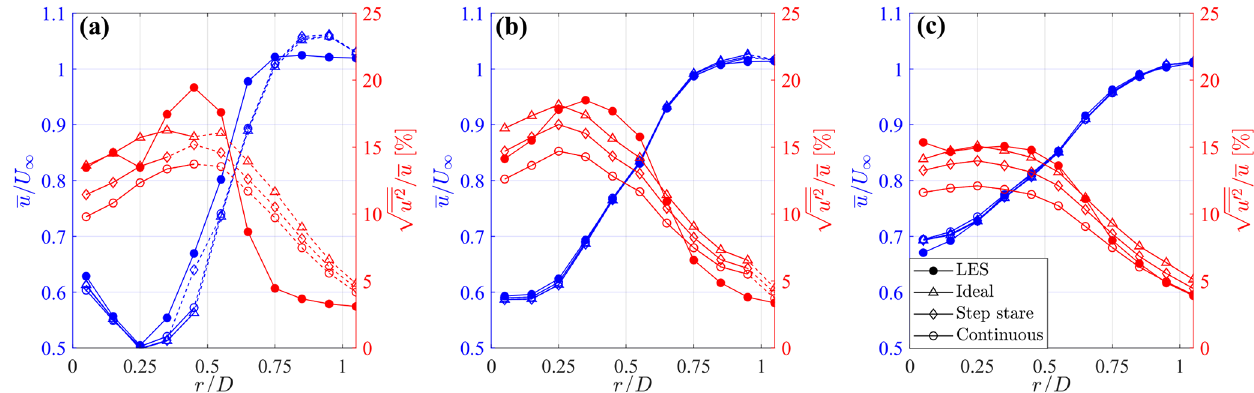
Figure 15. Azimuthally averaged profiles of mean streamwise velocity and turbulence intensity for three downstream locations. (a) x/D = 2 . 25, (b) x/D = 4 . 125, and (c) x/D = 6. The dashed lines correspond to regions rejected after the application of the Petersen–Middleton constraint.